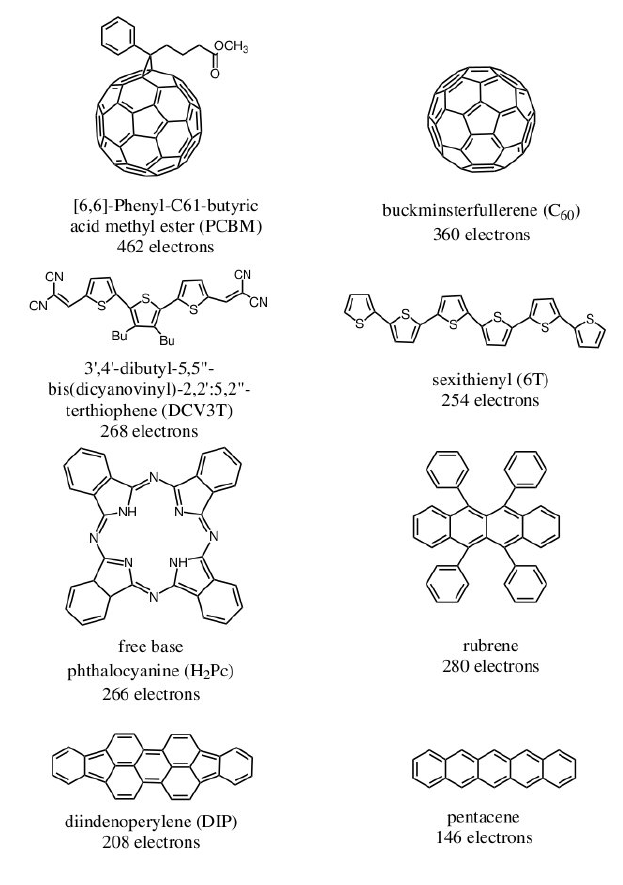
Figure 1. Eight typical molecules that are often used as acceptors or donors in organic